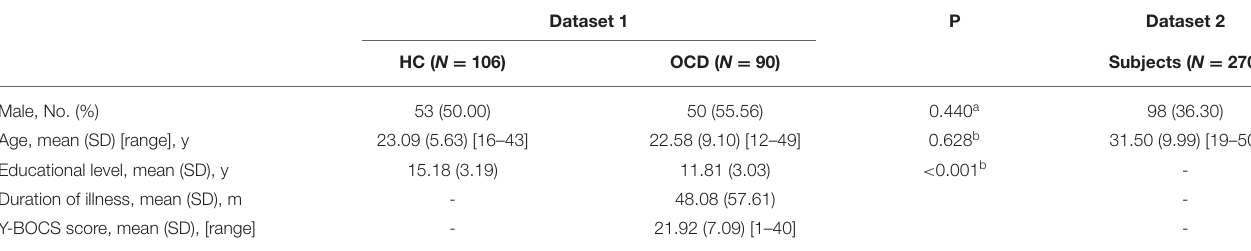
TABLE 1 | Demographic and clinical characteristics of participants.